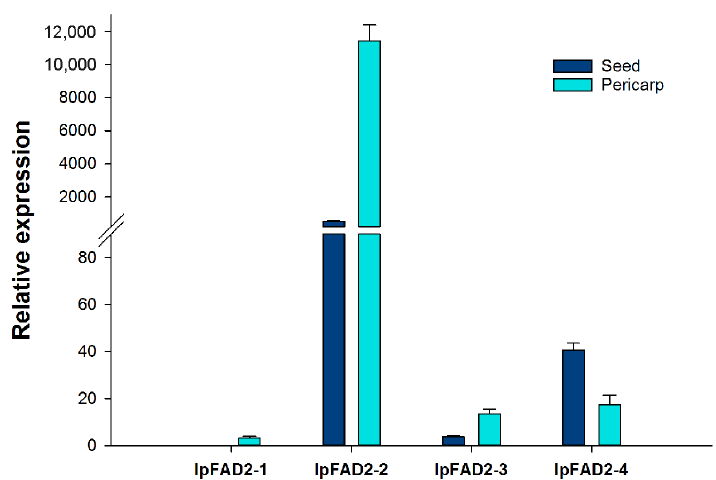
Figure 3. Relative expression levels of IpFAD2 genes in the pericarp and seed of Idesia polycarpa at 80 days post pollination. Relative expression values were calculated using the 2 − ∆∆ C t method by using EF1A gene as an internal control.